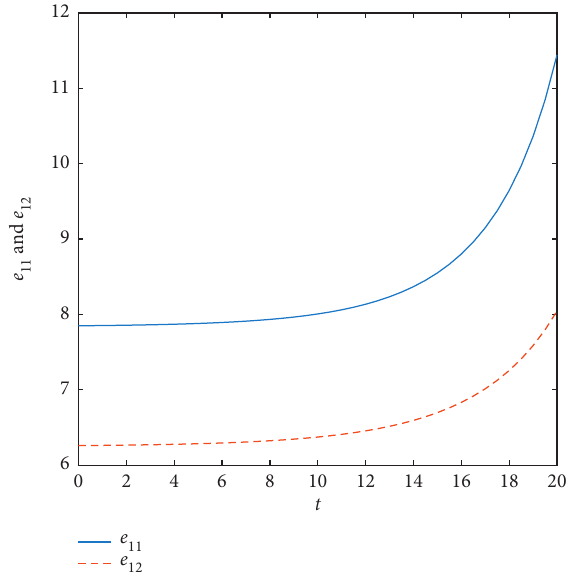
Figure 4: The pollution emission trajectory of the upstream region under noncooperation.